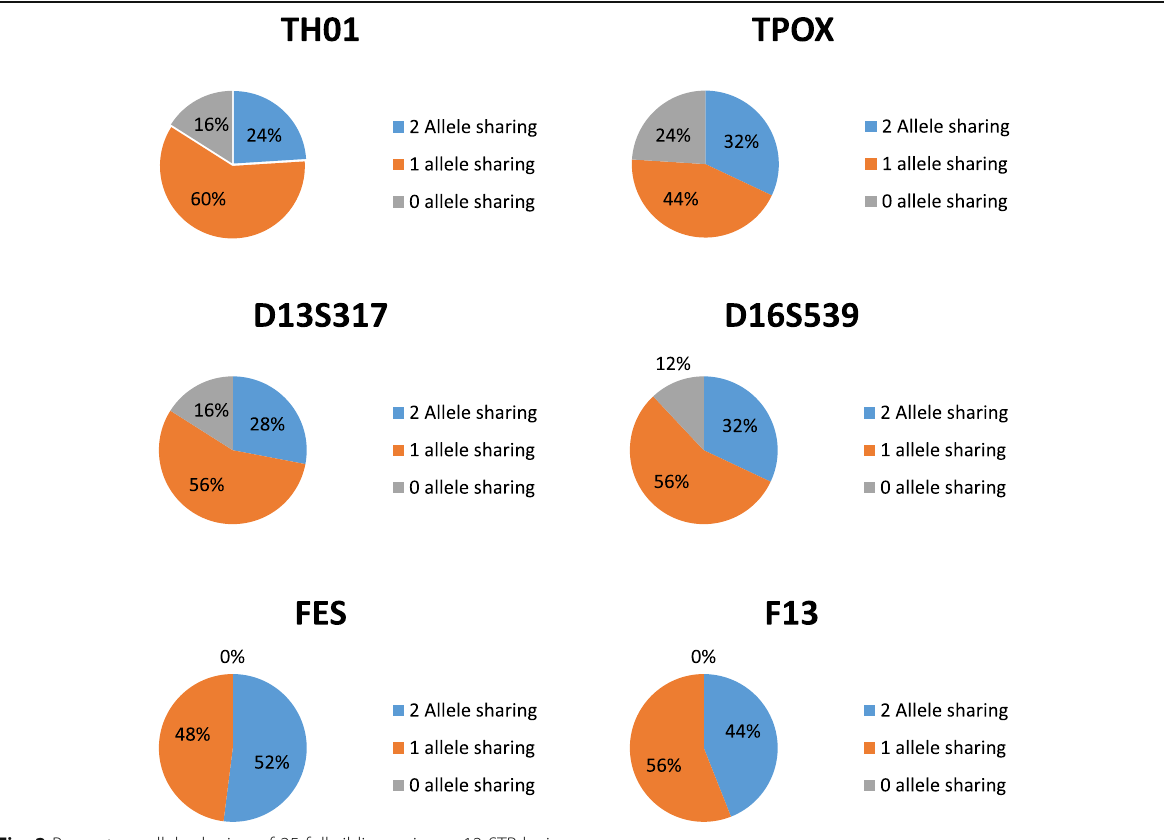
Fig. 2 Percentage allele sharing of 25 full sibling pairs on 12 STR